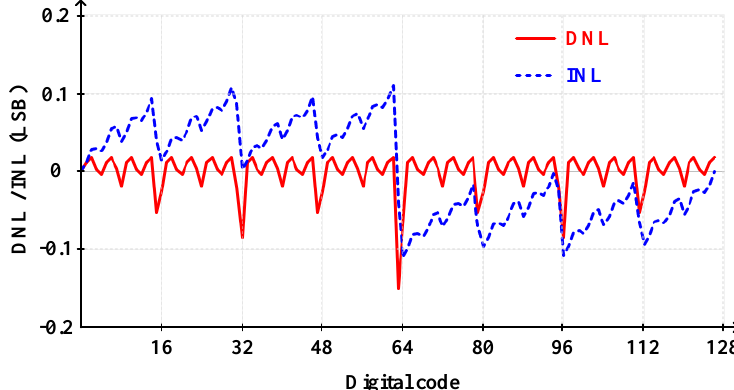
Figure 16. Di ff erential non-linearity (DNL) and integral non-linearity (INL) with post-layout extraction Figure 16. Differential non-linearity (DNL) and integral non-linearity (INL) with post-layout of CDAC and an additional 1% random extraction of CDAC and an additional 1% random mismatch.